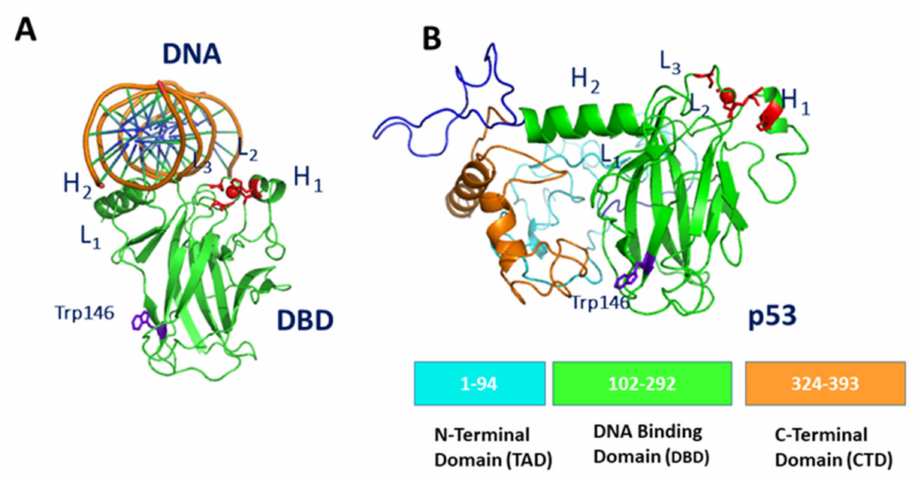
Figure 1. ( A ) Graphical representation of DBD complexed with DNA (as derived from chain B of 1TUP PDB entry [41]). ( B ) Graphical representation of the 3D model for the full-length monomer of p53 (see the text); at the bottom, the main domain structure is shown. In both views, Trp146 is marked in blue, while Zn and the residues forming the Zn-finger are marked in